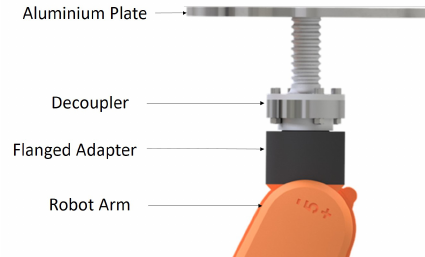
Figure 7. End effector used in the context of this work.